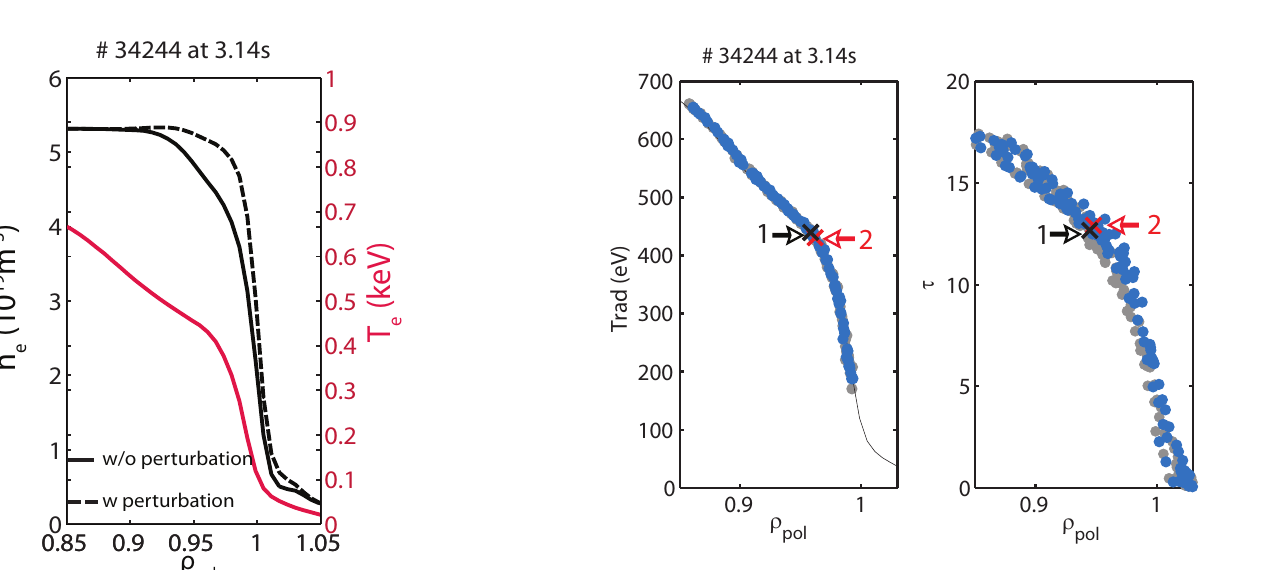
Figure 4. a) Modeled T rad profile of the ECE-I system shown against warm resonances. The dark gray circles correspond to a case without density perturbation with input density profile shown as a solid black line in figure 3. The blue circles corre- spond to a case where the perturbed density profile, shown as a dashed black line in figure 3, was used. The channel analyzed in this manuscript is labeled as 1 for the case without perturba- tion, and 2 with perturbation present. b) Optical depth for ECE-I channels for case 1 and 2, marked as gray and blue circles, re- spectively.